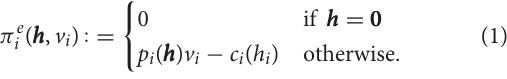
FIGURE 1 | Aggregate hash rate h ∗ ( α , v ) for each ¯ N